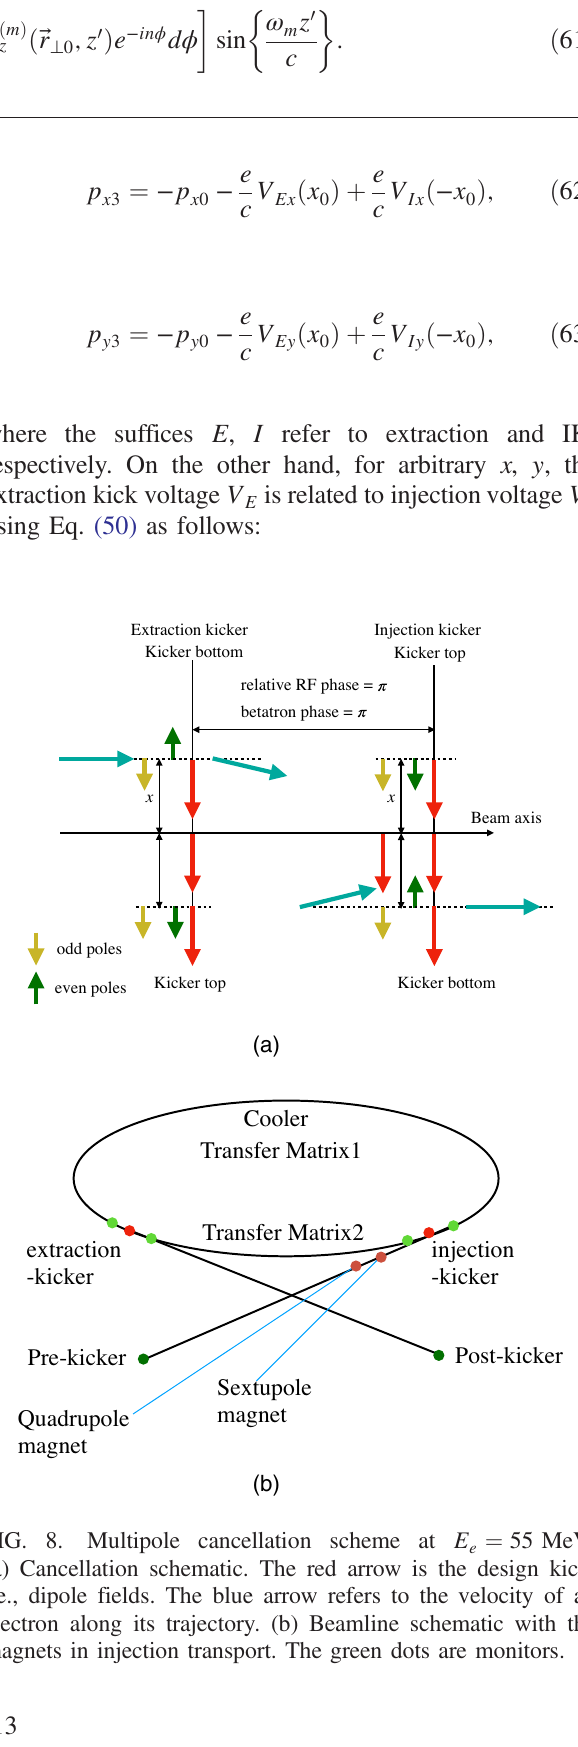
FIG. 8. Multipole cancellation scheme at E (a) Cancellation schematic. The red arrow is the design kick, i.e., dipole fields. The blue arrow refers to the velocity of an electron along its trajectory. (b) Beamline schematic with the magnets in injection transport. The green dots are